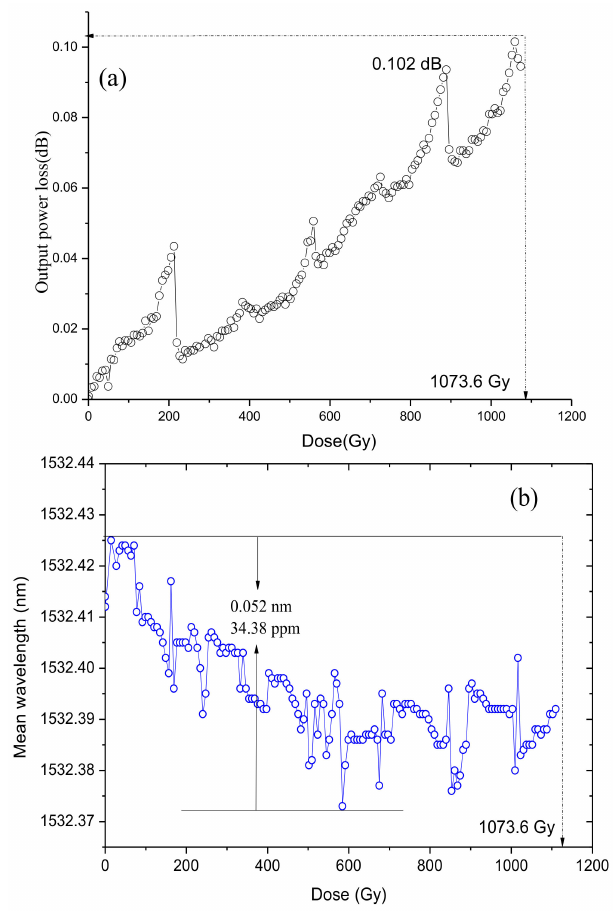
Figure 11. Measured ( a ) output power loss and ( b ) mean wavelength drift of an SFS with feedback control and trimming under Gamma ray irradiation of 1000